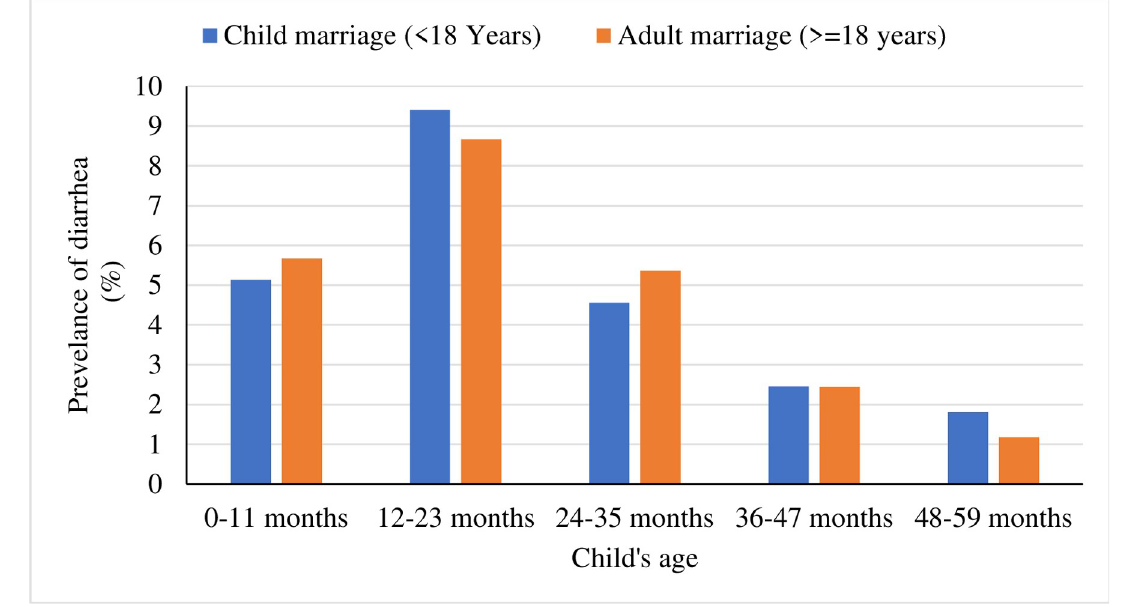
Fig 2. Prevalence of diarrhea by child’s age and status of marriage in Bangladesh, BDHS-2017/18.